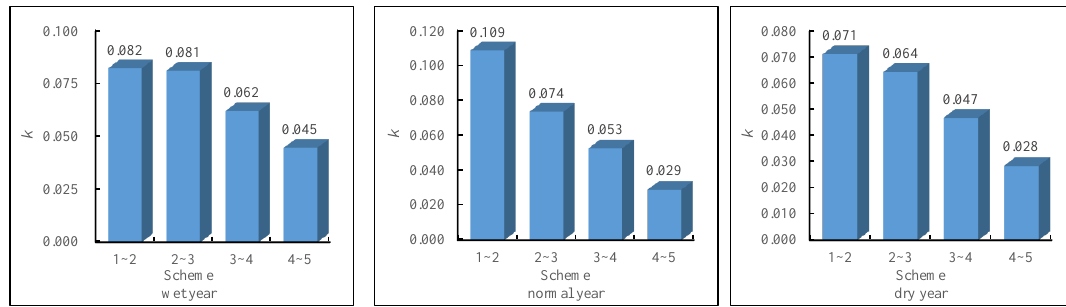
Figure 14. k value of different scheme intervals in each typical year.